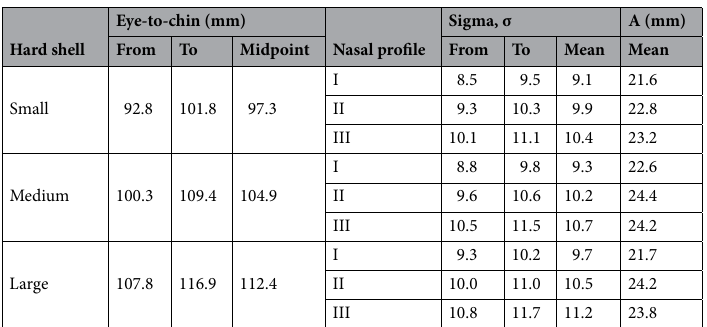
Table 1. Ranges and mean values of eye-to-chin distance, ‘σ’, and A for each of the nine semi-customised